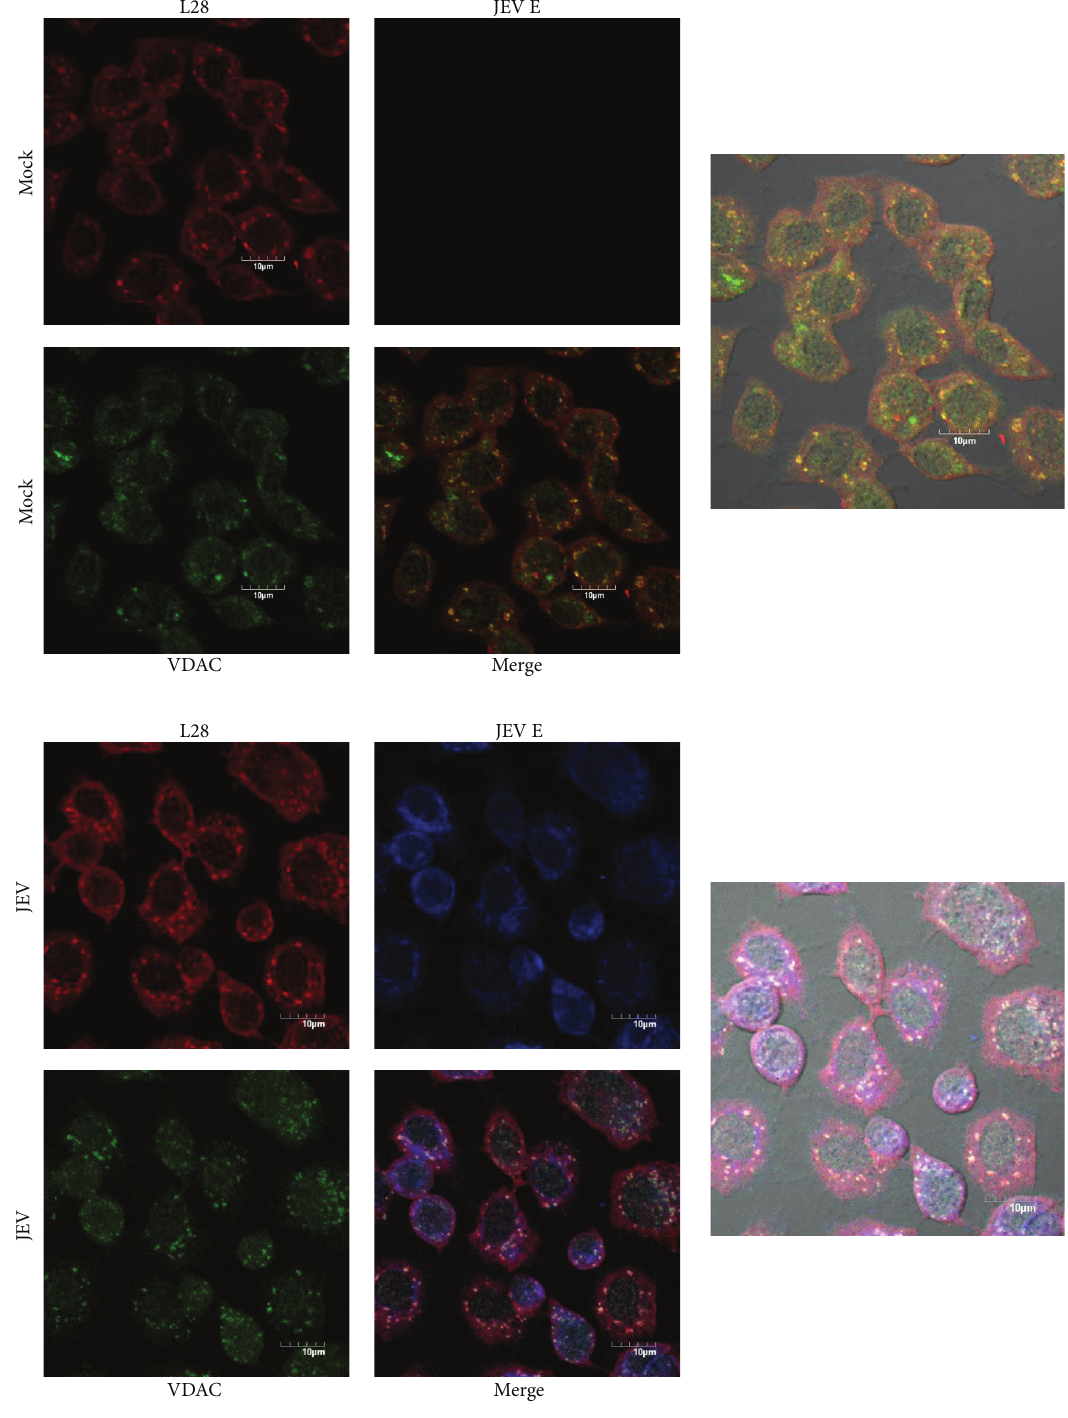
Figure 5: Location of JEV E protein, VDAC, and ribosomal L28 protein in JEV infected C6/36 cells. C6/36 cells grown on glass cover slips were mock infected or infected with JEV and examined for location of JEV E protein (blue), ribosomal L28 protein (red), and VDAC (green) using an Olympus FluoView 1000 confocal microscope. Representative individual and merged images are shown, and one panel has bright field